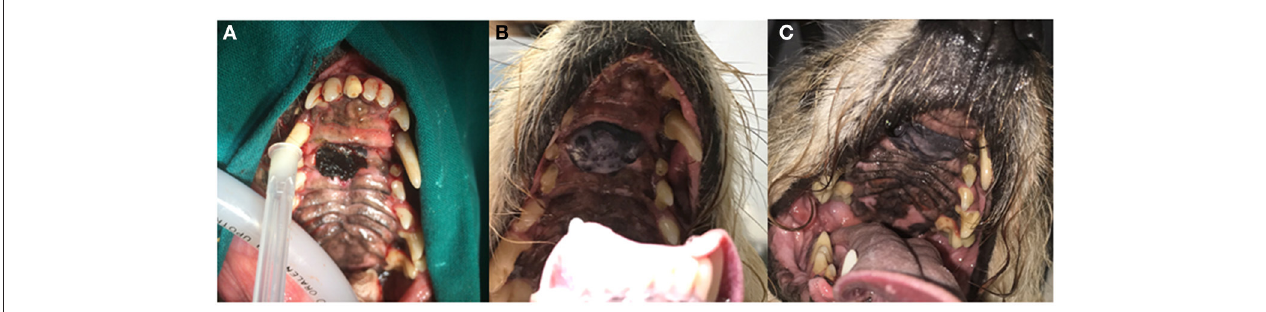
FIGURE 2 | Clinical images of patient no. 8 with an incompletely excised oral melanoma of the hard palate before treatment (A) , 270 days (B) , and 529 days (C) after treatment initiation. Stable disease (SD) was observed. The dog has not experienced any systemic side effects to treatment and was still alive at the time of writing of this report.